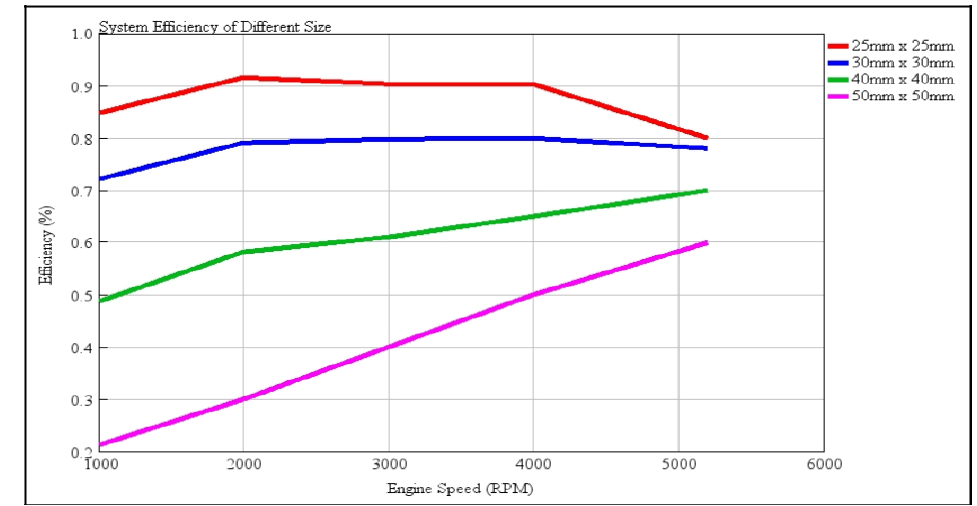
Figure 18. System efficiency of different module size (1 module).